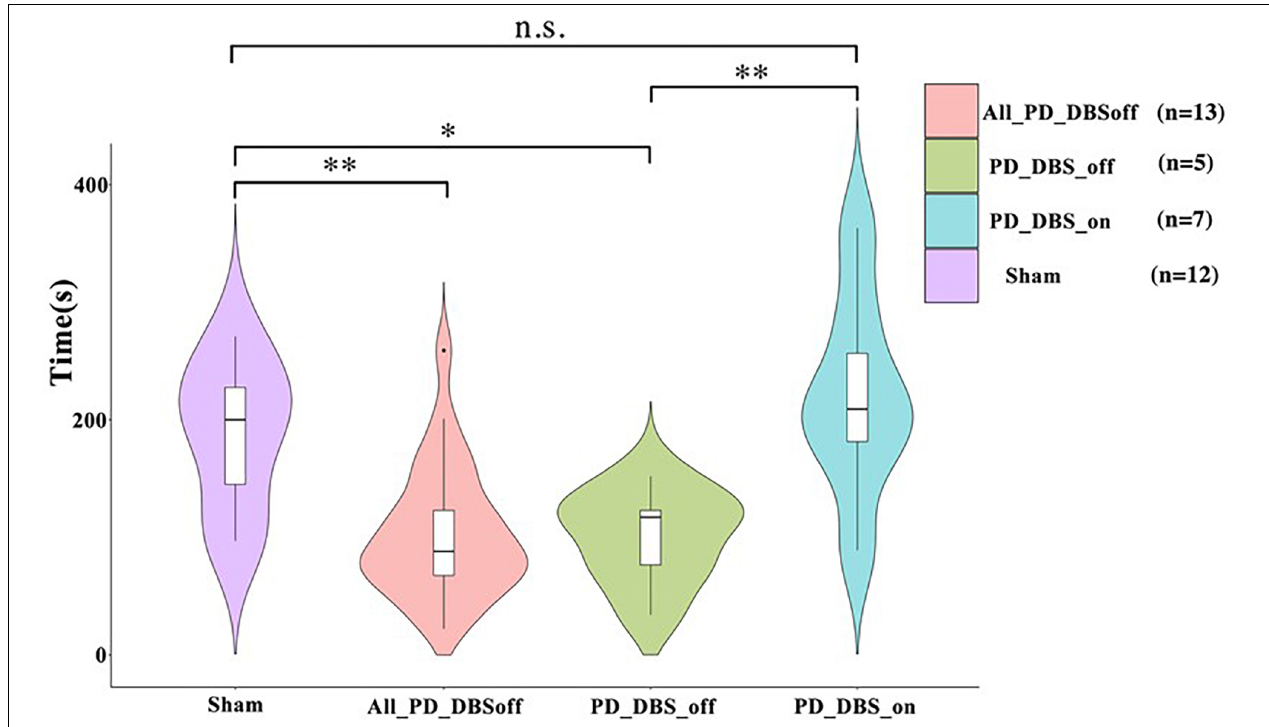
FIGURE 12 | The rotarod test challenges the motor and balance capabilities of animals by forcing them to move at the speed of the elevated rotating rod they are placed on. All the animals underwent two test sessions while no DBS treatment was applied. A subgroup of PD animals performed a third test session while receiving DBS ( n = 7), whereas the rest of the PD group performed the third round while DBS was off ( n = 6). The maximum time and speed each animal could remain on the rotarod was recorded and compared across groups. The performance of the PD and sham group during the first two rounds were compared (sham vs. All PDDBSoff). The PD group remained a significantly shorter period of time on the rotarod compared to the sham group. As for the third round, the performance difference between the PDDBSon and sham animals was not significant. However, the performance of the PDDBSoff subgroup was significantly worse compared to the sham and PDDBSon. Level of significance: (* p < 0.05, ** p < 0.01, and n.s. stands for not significant). Figure adapted from Mottaghi